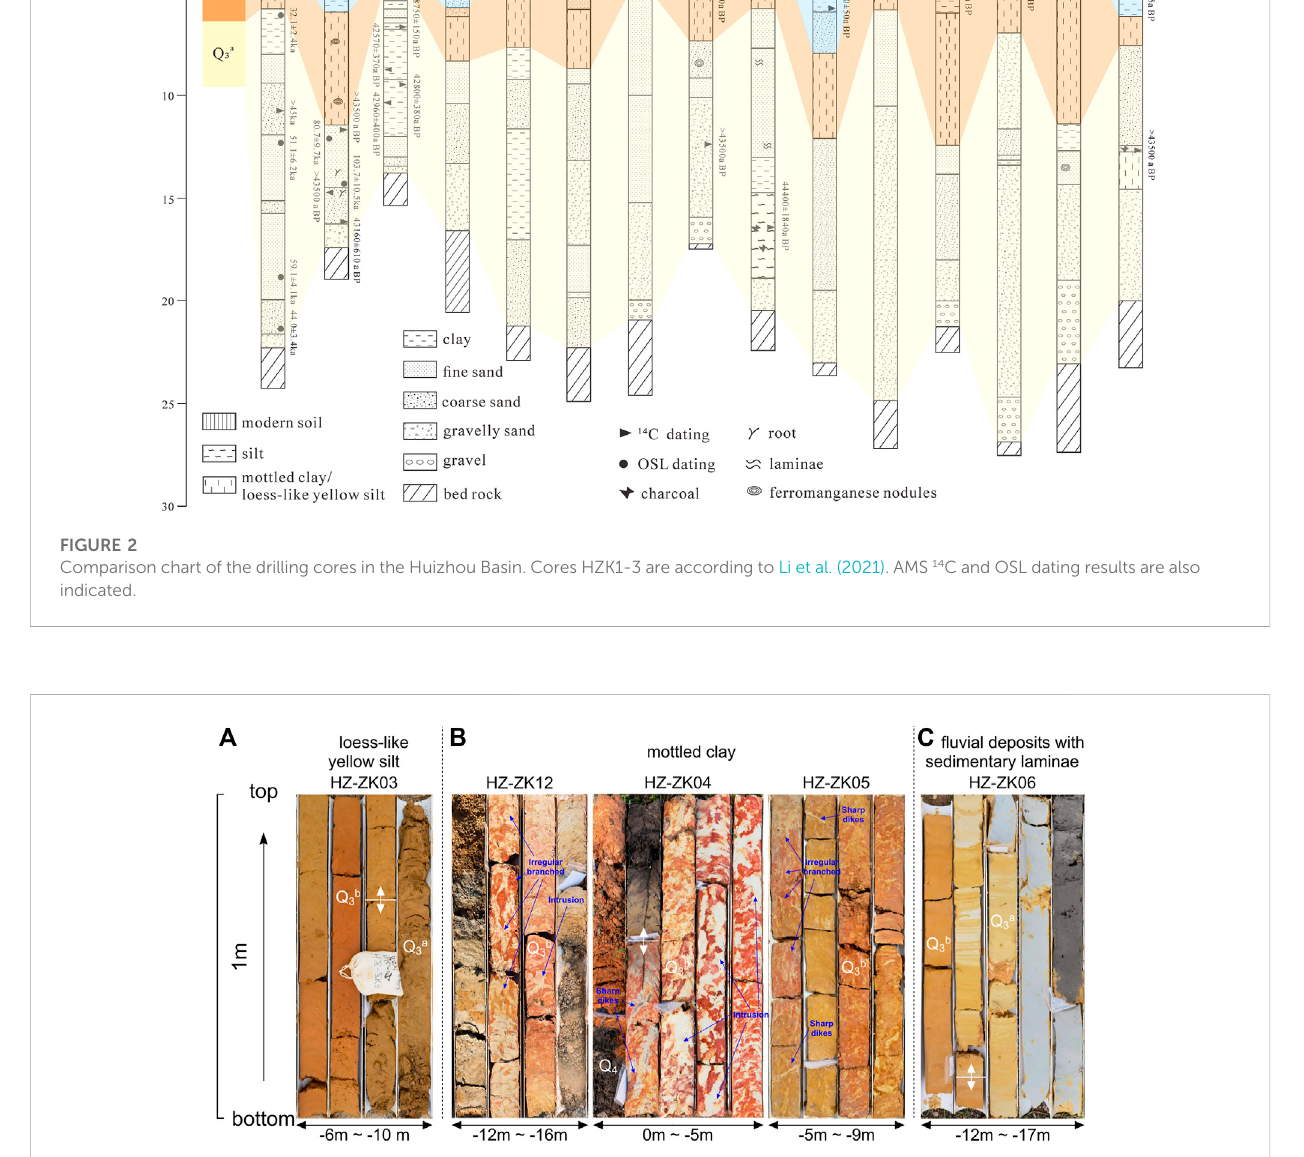
PhotographofdifferentlithologicallayersintheHuizhouBasin. (A) Homogeneousloess-like yellowsilt. (B) Mottledclay,exhibitingayellow,redand grey-white mixed color and vertical structure. (C) Fluvial sand deposit with horizontal